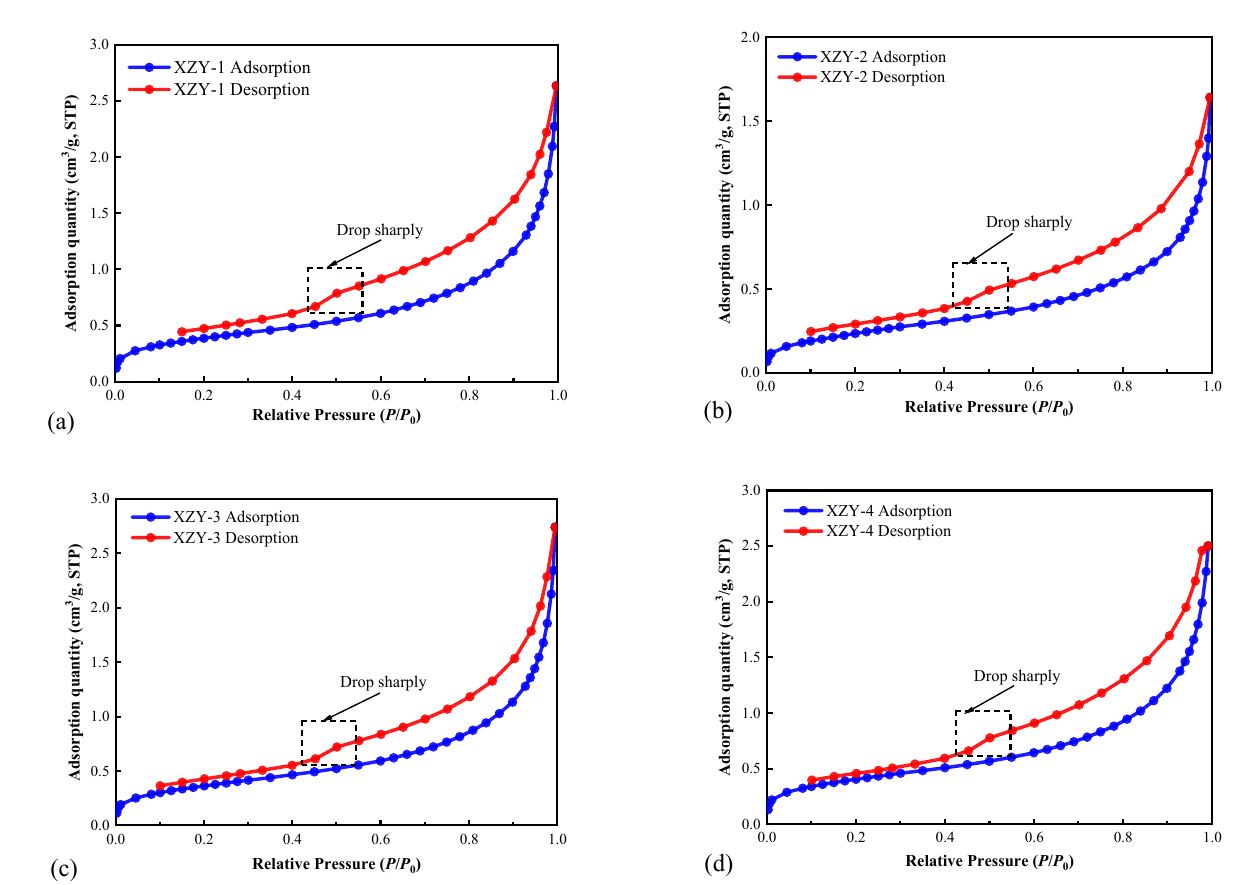
Figure 3. Low-temperature liquid N 2 adsorption and desorption curves: ( a ) XZY-1; ( b ) XZY-2; ( c ) XZY-3; ( d ) XZY-4.